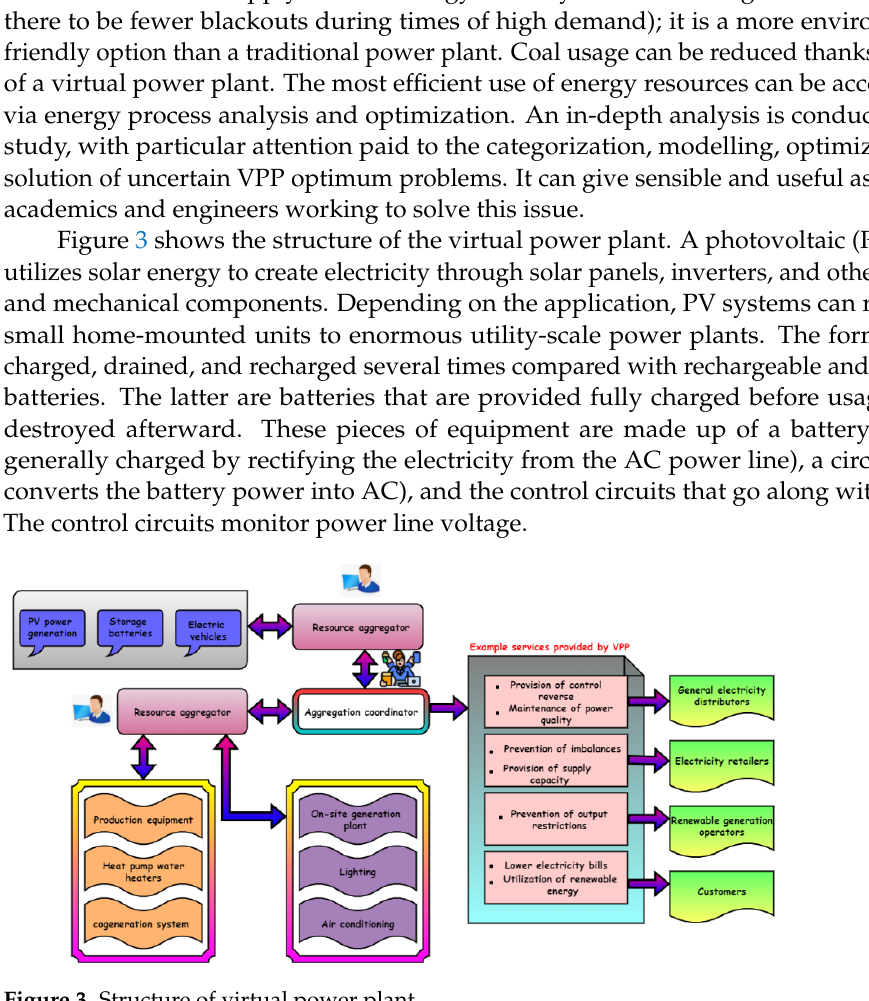
Figure 3. Structure of virtual power plant.